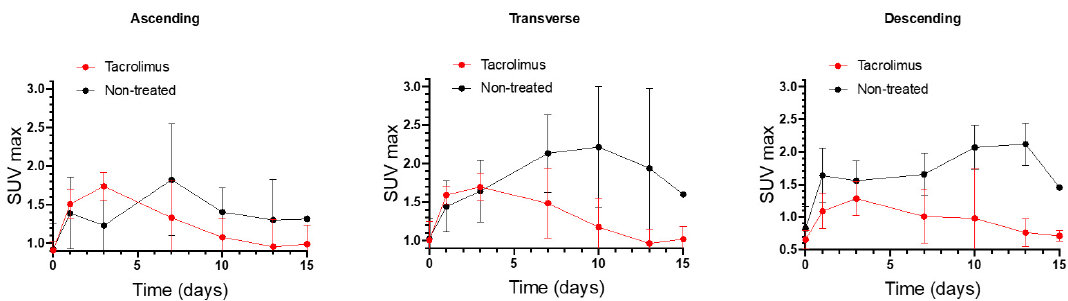
Figure 6. Longitudinal SUV max values for ascending, transverse and descending colonic segments over time for non-treated rats and animals treated with the 3D printed tacrolimus suppositories. Error bars represent standard deviation (SD).